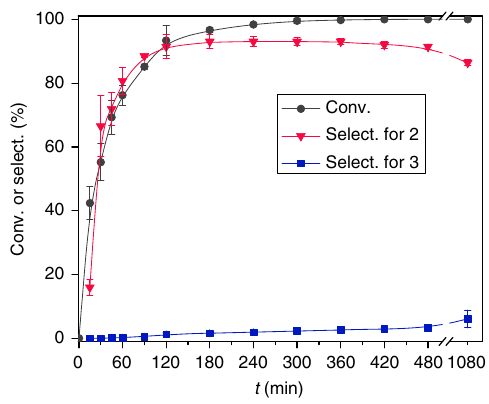
Fig. 8 Time course of the catalytic conversion of 4- hydroxymethylbenzaldehyde over HAc-modi fi ed MnO x . Reaction conditions: 2.5mmol 4-hydroxymethylbenzaldehyde, 0.85 mmol MnO x , HAc/MnO x